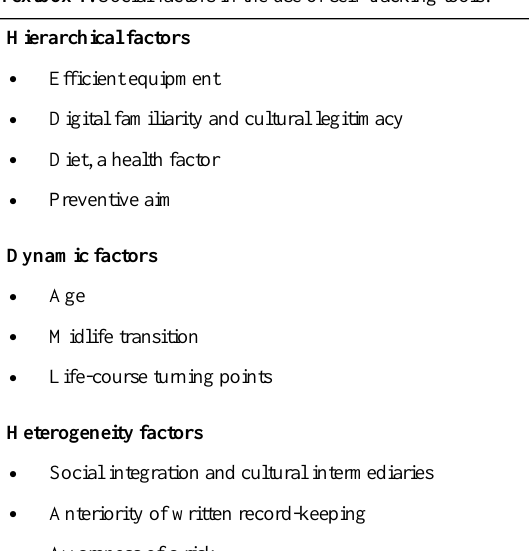
Textbox 1. Social factors in the use of self-tracking